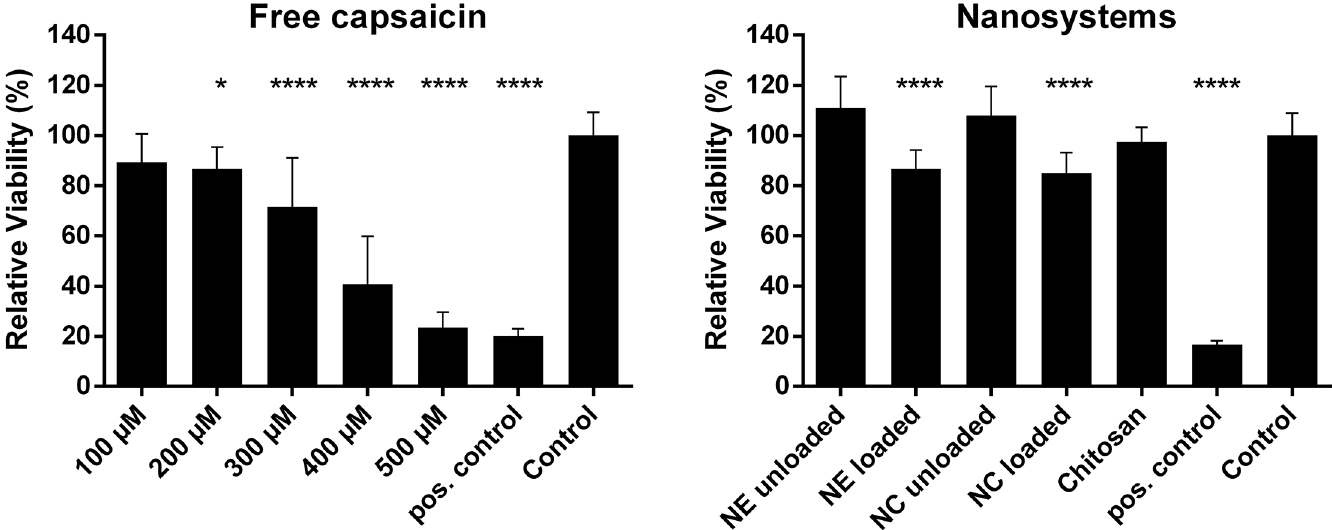
Fig 3. Cytotoxicity of different formulations against TR146 cells determined using the MTT assay. Relative cell viability following treatment with free capsaicin at increasing concentrations (Left). Relative cell viability following treatment with the different nanoformulations or their constituents at a universal concentration of 500 μ M capsaicin (Right). For all experiments, cells were incubated for 3 h. Mean values ± SD. (n = 3, * p < 0.05, **** p < 0.0001). NC = nanocapsules; NE =